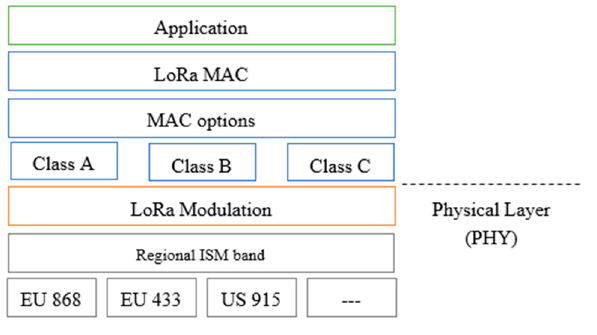
Figure 1. LoRaWAN stack .